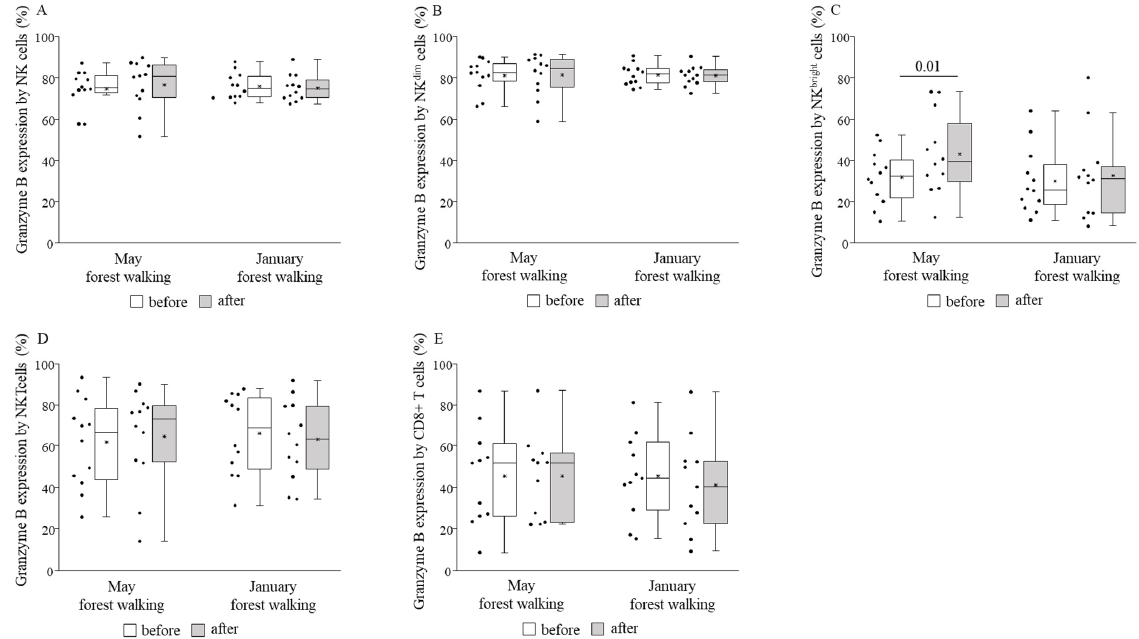
Figure 7. Granzyme B expressions by total NK ( A ), NK dim ( B ), NK bright ( C ), NKT ( D ), and CD8+ T ( E ) cells prior to and following the late spring (May) and winter (January) forest walks. The middle line within the box represents the median, the middle dot within the box represents the mean, the boxes indicate the interquartile ranges between the 25th and 75th percentiles, and the whiskers show the most extreme observations in the box plot. Individual dots left from the boxes represent individual data values. Differences were considered statistically significant for p -values < 0.05. Statistically significant p -values are indicated on the horizontal lines outside the